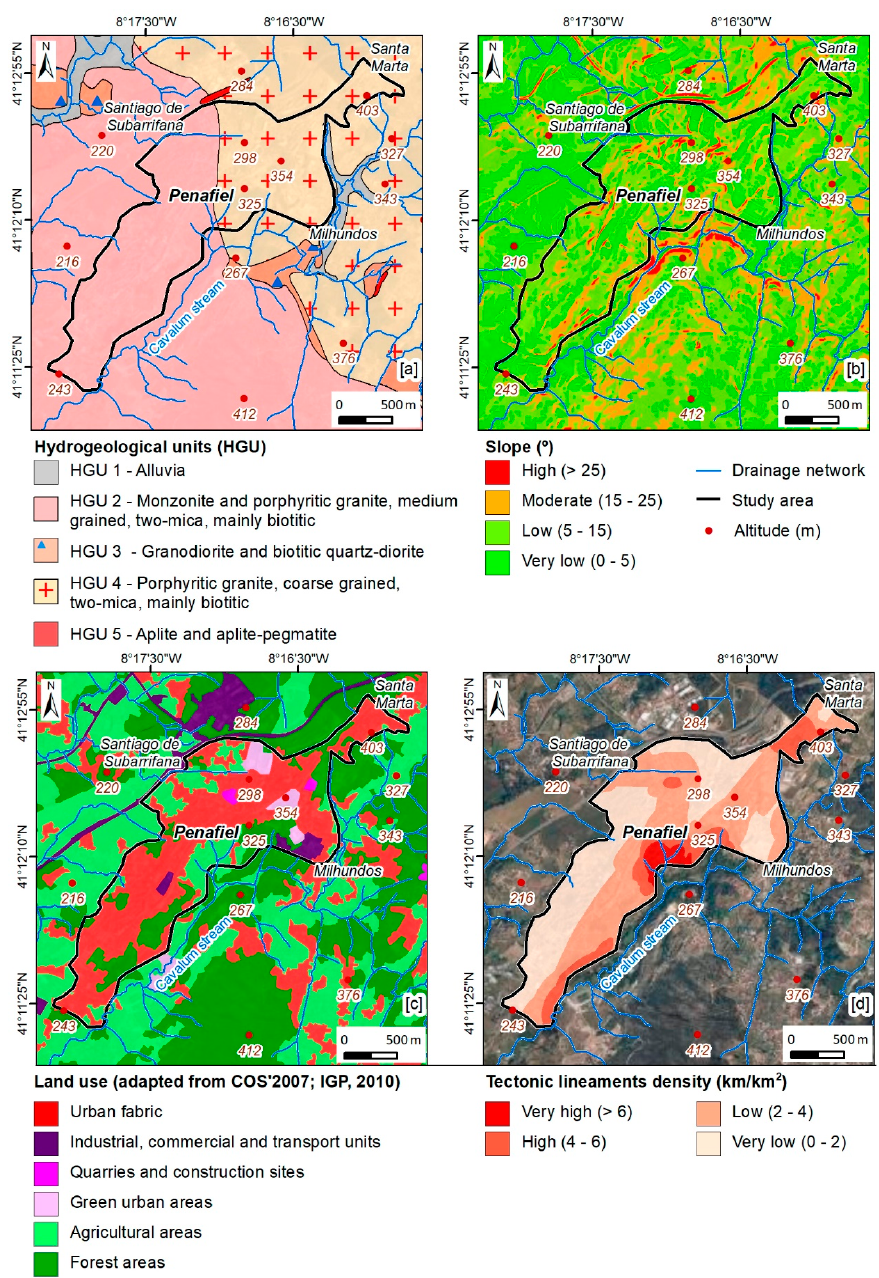
Figure 9. Urban Potential Infiltration Index (IPI-Urban) in the Penafiel urban area (NW Portugal): hydrogeological units ( a ), slope ( b ), land use ( c ), and tectonic lineaments density ( d ).